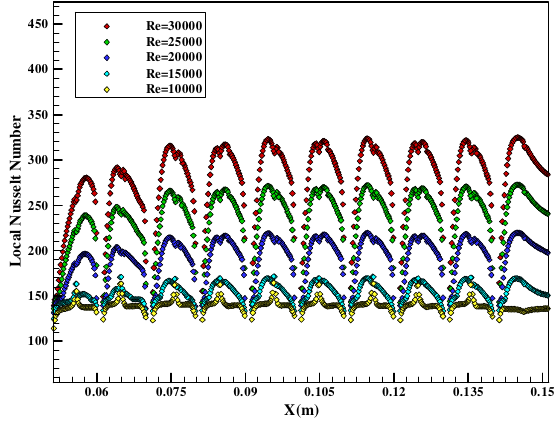
Fig. 4.Varation of local Nusselt number with x- position with trapzoidal ribs